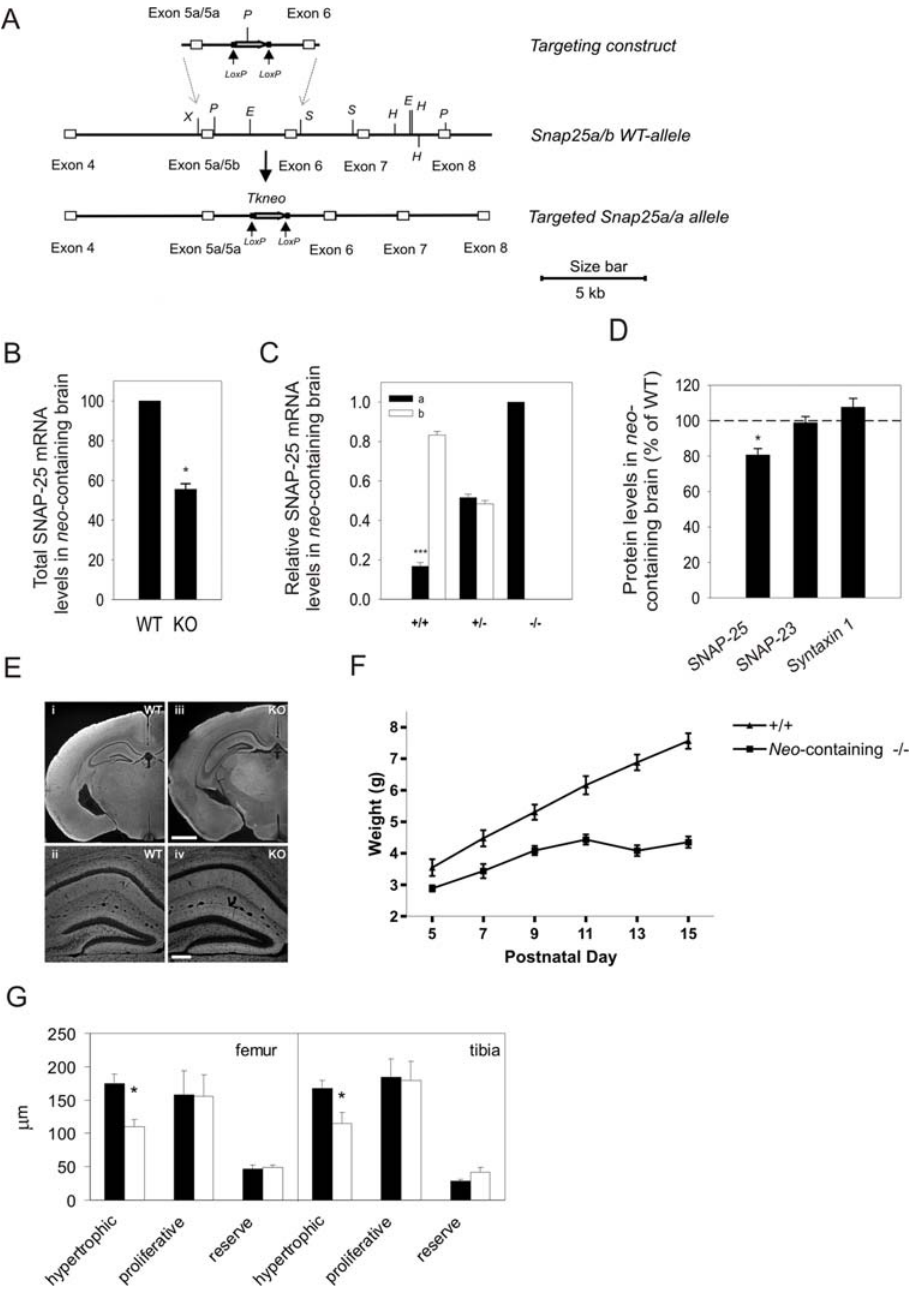
Figure 1. Generation of SNAP-25b Deficient Mouse Mutants. (A) Schematic diagram demonstrating the targeting construct and the development of a modified Snap25 allele with eliminated SNAP-25b expression. The mouse genomic sequence was derived from the WT Snap25 gene and addition of an additional exon 5a was performed using PCR. A Tkneo selection gene, surrounded by loxP repeats, was inserted at the EcoRI (E) site located downstream of the two tandemly arranged exons 5a and upstream of exon 6. Letters denote restriction sites: E, EcoRI ; H, HindIII ; P, PstI ; S, SacI ; X, XbaI . (B) Total SNAP-25 mRNA level in mouse brain at PN14 was investigated by semi-quantitative RT-PCR. Levels of SNAP-25 mRNA, quantified relative to GAPDH mRNA levels, were determined in neo- containing SNAP-25b deficient mutants (KO) and compared to WT littermates. SNAP-25 mRNA in neo- containing SNAP-25b deficient mutant brain was significantly reduced to 55.5 6 2.7% compared to WT (mean 6 S.E.M., n=6 mice for each genotype, each sample repeated three times, * p= 0.0312, Wilcoxon’s signed-rank test). (C) A semi-quantitative RT-PCR restriction enzyme assay was used to determine relative levels of SNAP-25a and SNAP-25b isoform mRNAs in WT ( + / + ), neo- containing heterozygous ( + / 2 ) and neo- containing homozygous ( 2 / 2 ) mutant brains at PN14. A PvuI restriction site exclusive for exon 5a and a StyI site only present in exon 5b was used to determine relative levels of SNAP-25a and SNAP-25b. WT mice had 16.7 6 1.9% SNAP-25a mRNA, neo- containing heterozygous mutants 51.6 6 1.7% SNAP-25a mRNA, and homozygous SNAP-25b deficient mutants only, the SNAP-25a mRNA isoform (n=5 mice of each genotype, run in two replicates, mean 6 S.E.M., *** p , 0.0001, Student’s t-test). (D) Western blotting was used to analyze synaptic protein levels in brain at PN14-15, standardized against a -tubulin. The level of SNAP-25 protein in neo -containing SNAP-25b deficient mutants was 80.7 6 3.6% compared to WT (mean 6 S.E.M., * p= 0.0312, Wilcoxon’s signed-rank test), whereas expression of SNAP-23 protein was 98.9 6 3.5% ( p= 1, n.s.) and that of syntaxin 1 protein 107.6 6 4.9% ( p= 0.4375, n.s.), compared to WT animals. The levels of SNAP-25 protein differed significantly in neo -containing SNAP-25b